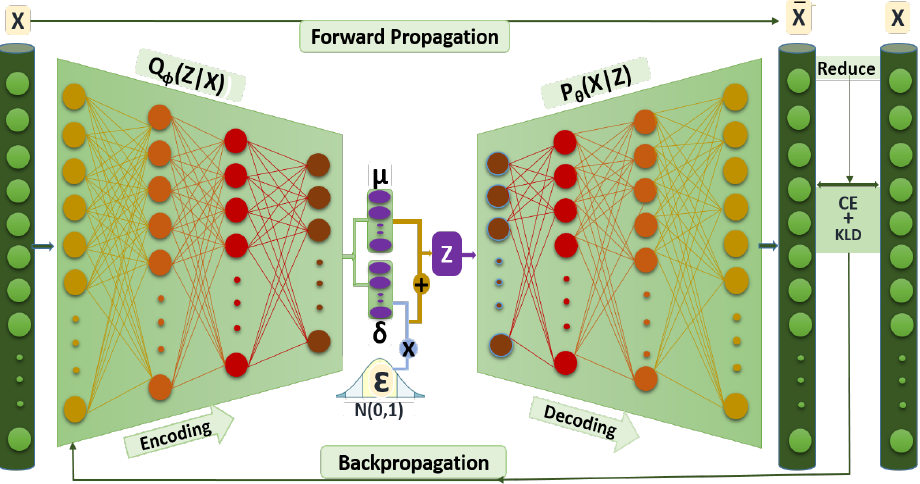
Figure 1. Variational AutoEncoder with CE